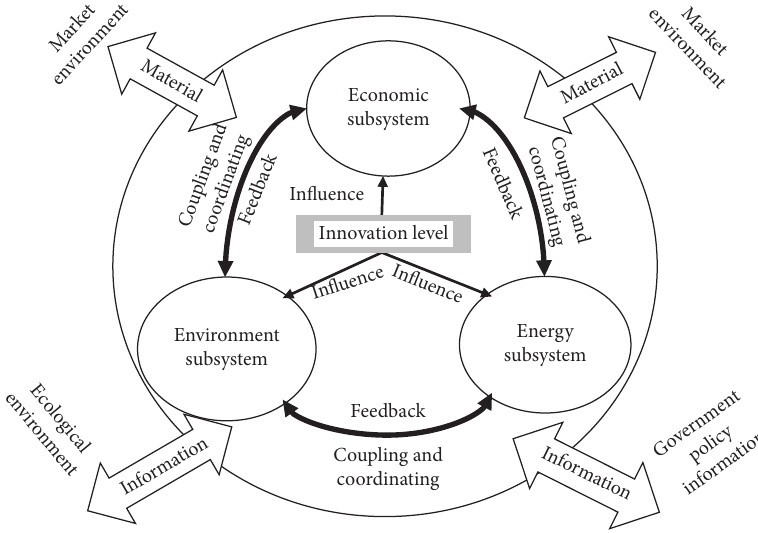
Figure 1: Self-organization system model for coal enterprises’ green low-carbon